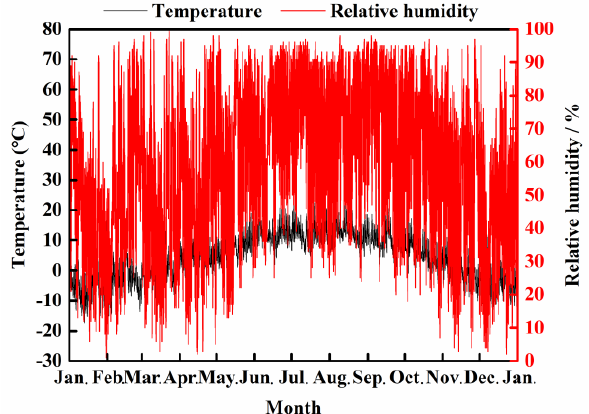
Table 3. Chemical composition of rammed earth.